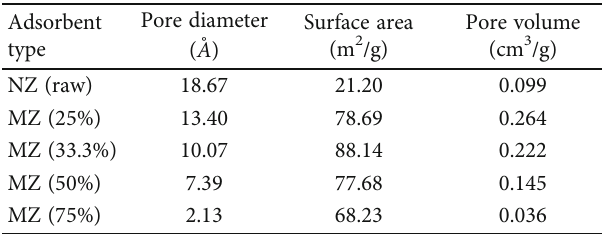
Table 3: Surface and pore characteristics of natural and magnetic